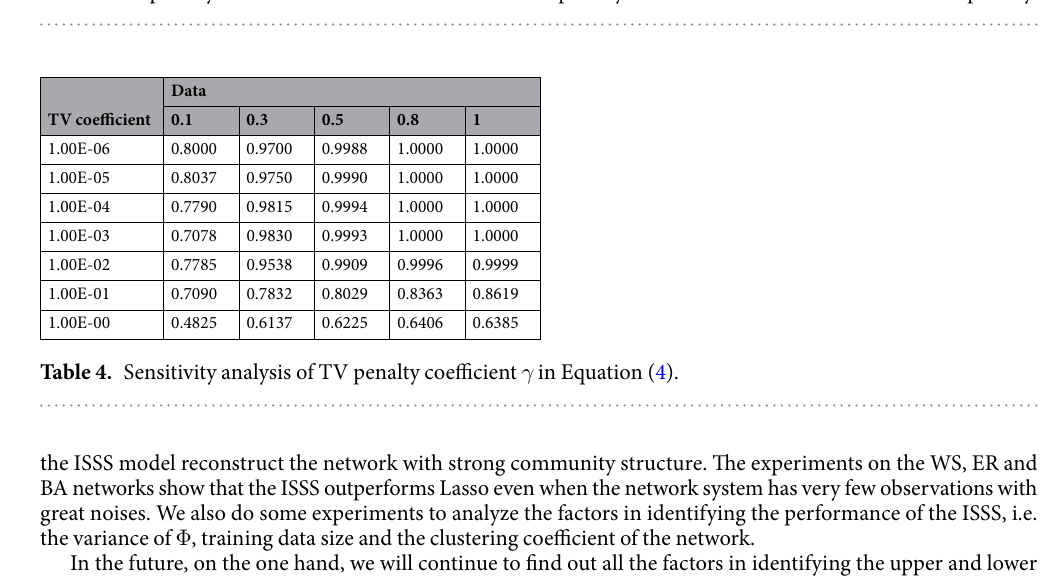
Table 3. The performance of models with different penalties on a BA network. ISSS/TV is the ISSS model without TV penalty. ISSS/L1 is the ISSS model without L1 penalty. ISSS/L2 is the ISSS model without L2 penalty.